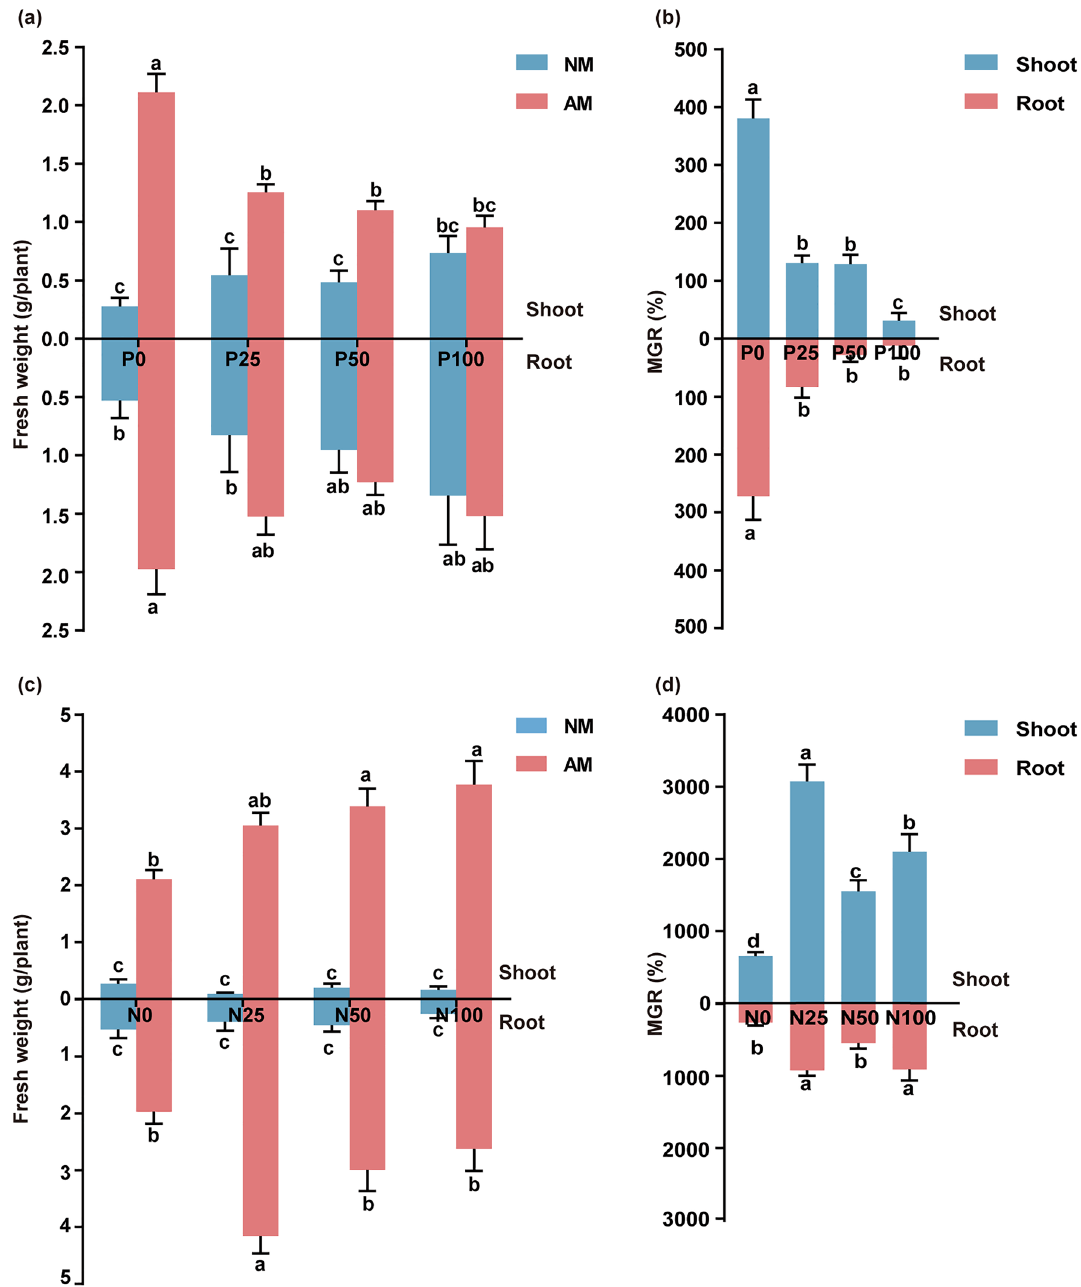
Figure 2. Mycorrhizal efficiency on plant growth under different levels of P (0, 25, 50, and 100 mg P fertilizer added per kilogram of soil; P0, P25, P50, P100) and N (0, 25, 50, and 100 mg N fertilizer added per kilogram of soil; N0, N25, N50, N100) fertilizer. ( a,c ) The fresh weight of S. miltiorrhiza shoots and roots under different treatments. The mycorrhizal growth response (MGR) of plants along a P ( b ) or N ( d ) fertilization gradient consisting of four input levels. The means ± standard errors are shown (n = 6). Different lowercase letters indicate significant differences between different treatments according to two-way ANOVA ( a,c ) or one-way ANOVA ( b,d ) followed by Tukey’s test for multiple comparisons ( P < Regardless of the N addition dose, compared with non-mycorrhizal plants, AMF colonization significantly increased the biomass of S. miltiorrhiza shoots and roots (Fig. 2c, S1b). Under mycorrhizal treatments, the fresh weight of shoots increased gradually with increasing N application. However, the fresh weight of roots under N25 was the highest, and a subsequent increase in nitrogen addition decreased the root biomass. Application of a low level of N (N25) resulted in increased biomass of the shoots by 29-fold and that of the roots by 9.4-fold compared with that in non-mycorrhizal plants (Fig. 2c).